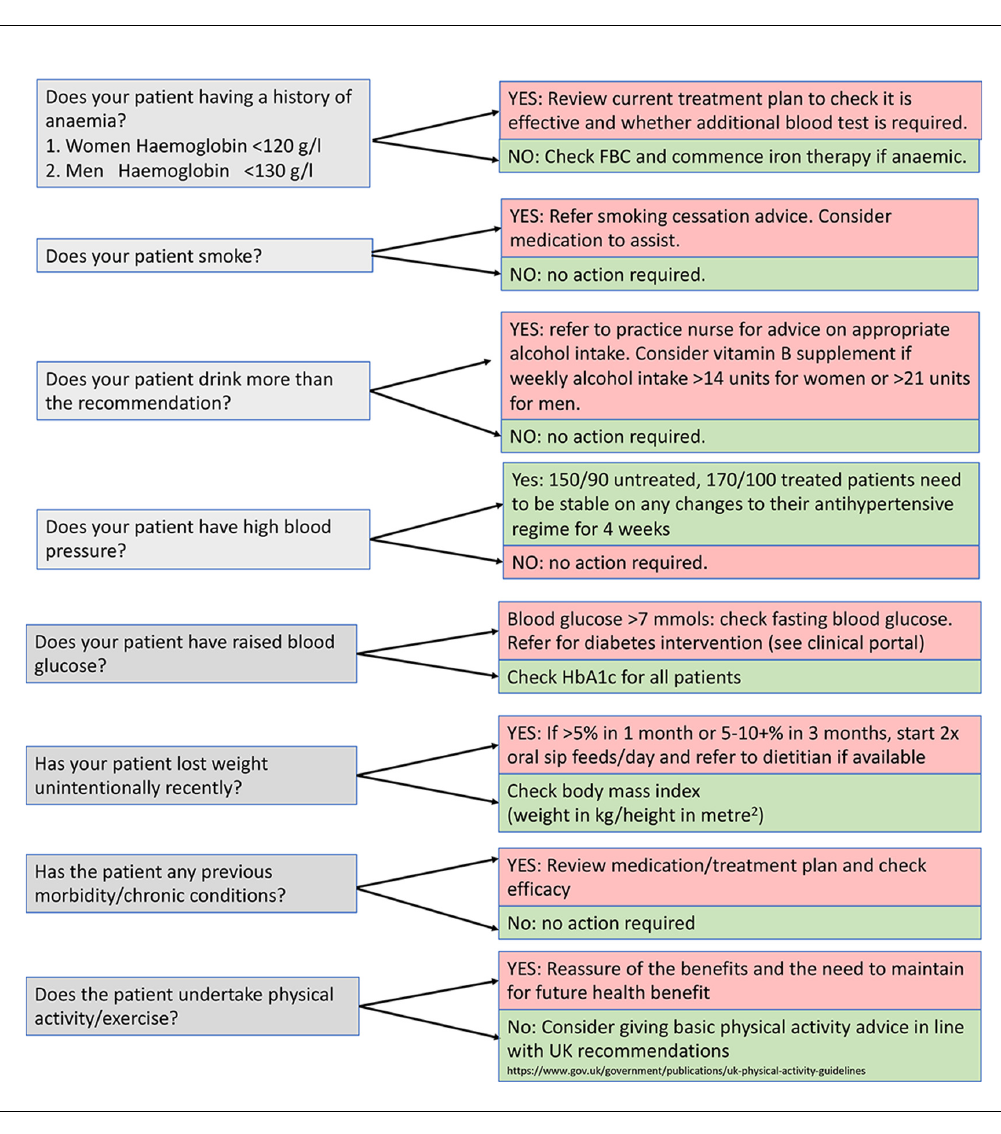
Figure 2. Optimisation bundle assessment FBC = full blood count. HbA1C = haemoglobin